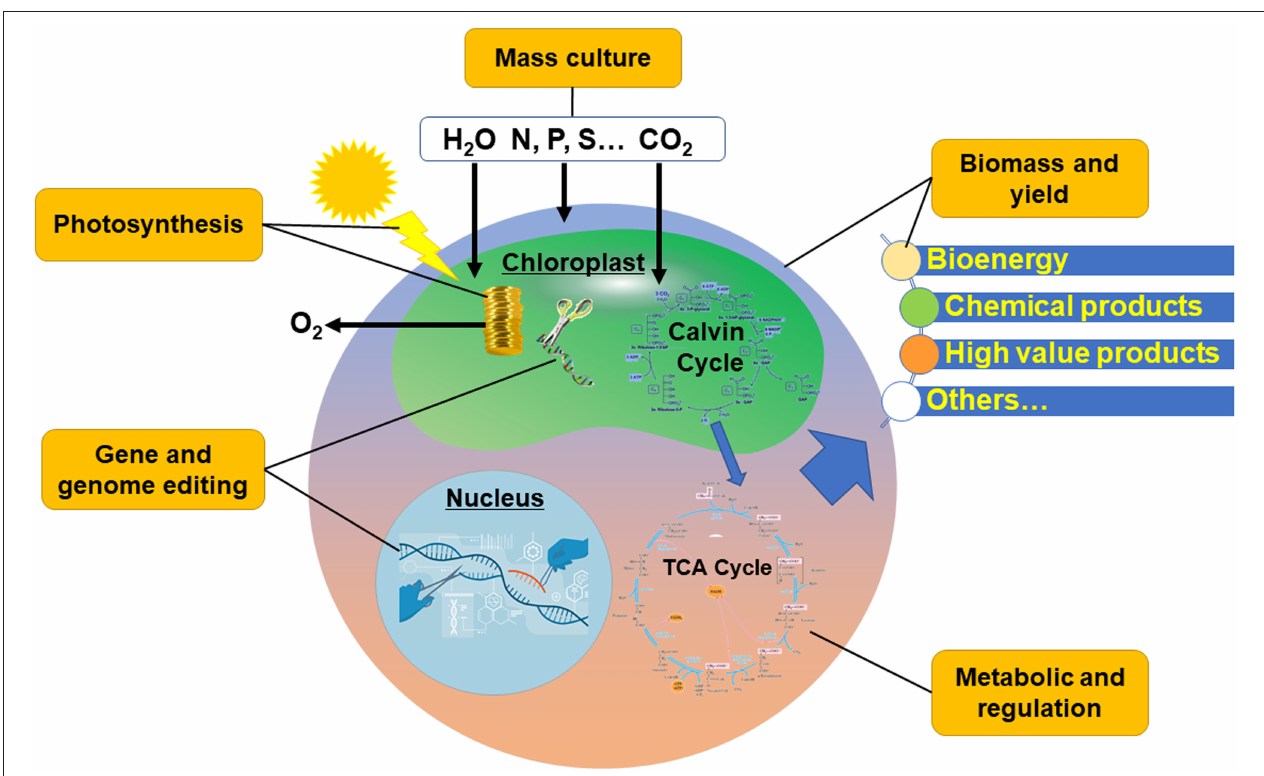
FIGURE 1 | The optimized key points for microalgae-based green